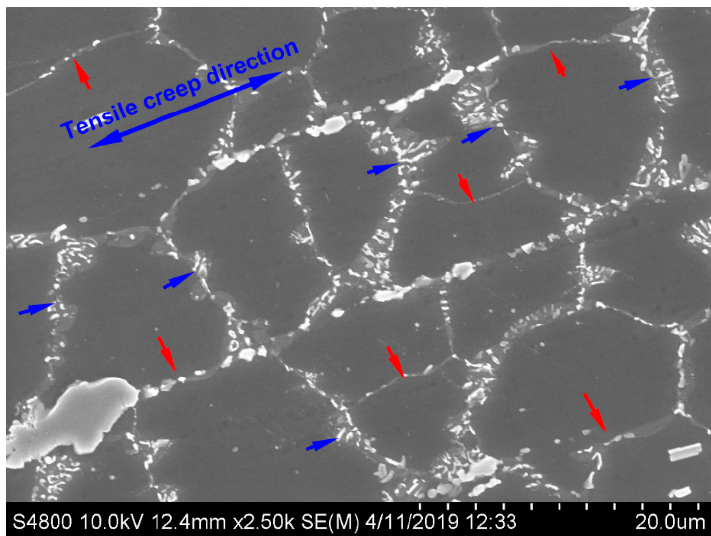
Figure 10. The atom and vacancy diffusion flow schematic diagram in the crept as-extruded AZXSE91000 alloy.